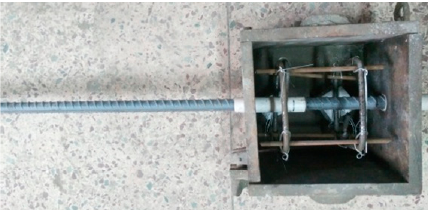
Figure 2. Mould for pull-out bond specimens with stirrups.